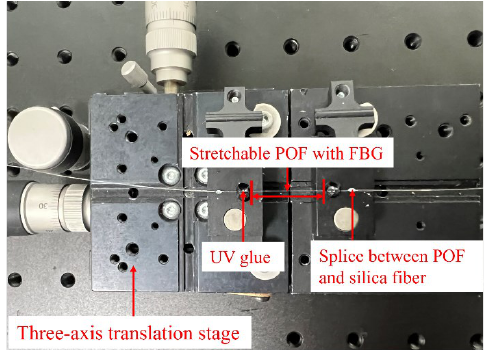
Figure 5. Experimental setup for strain measurement.